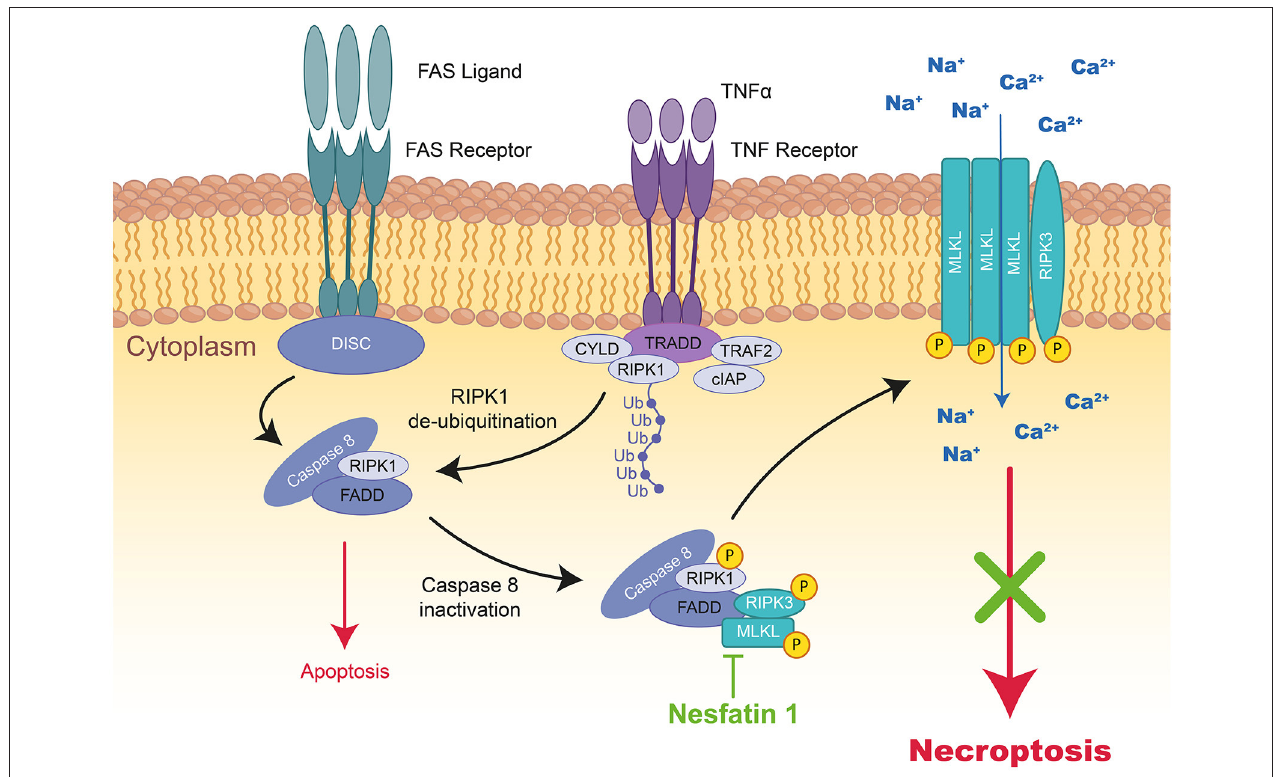
FIGURE 3 | Schematic representation of necroptosis and the mode of action of Nesfatin 1 therapeutic peptide during MIRI. TNF α activates the TNF receptor, which induces the formation of a complex formed by TRADD, TRAF2, RIPK1, CYLD, and cIAP1 at the cytoplasmic membrane. In the absence of cIAP1, RIPK1, FADD, and Caspase-8 form cytosolic DICS complex, Caspase-dependent pathways are activated inducing apoptosis. However, by Caspase-8 inactivation, RIPK1 interacts with RIPk3 and MLKL to form a third complex inducing necroptosis. The kinase of RIPK1 phosphorylates RIPK3 and MLKL resulting in their translocation to the plasma membrane, where the complex mediates membrane permeabilization. The therapeutic peptide Nesfatin-1 (highlighted in green) can reduce RIPK1, RIPK3, and MLKL expression and therefore necroptosis. TNF, tumor necrosis factor; TRADD, tumor necrosis factor receptor type 1-associated death domain; TRAF2, TNF receptor-associated factor 2; RIPK1/3, receptor-interacting serine/threonine-protein kinase 1; CYLD, lysine 63 deubiquitinase; cIAP1, cellular inhibitor of apoptosis protein 1; MLKL, mixed lineage kinase domain like pseudo